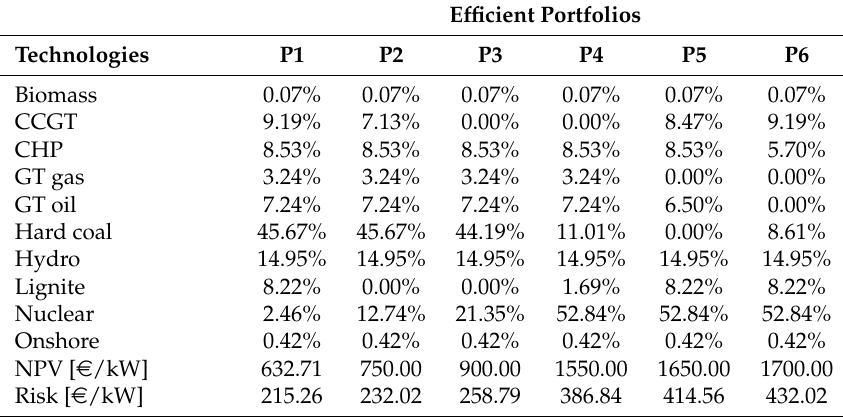
Table A1. Efficient portfolios according to FSMAD Model 1 for existing technologies.